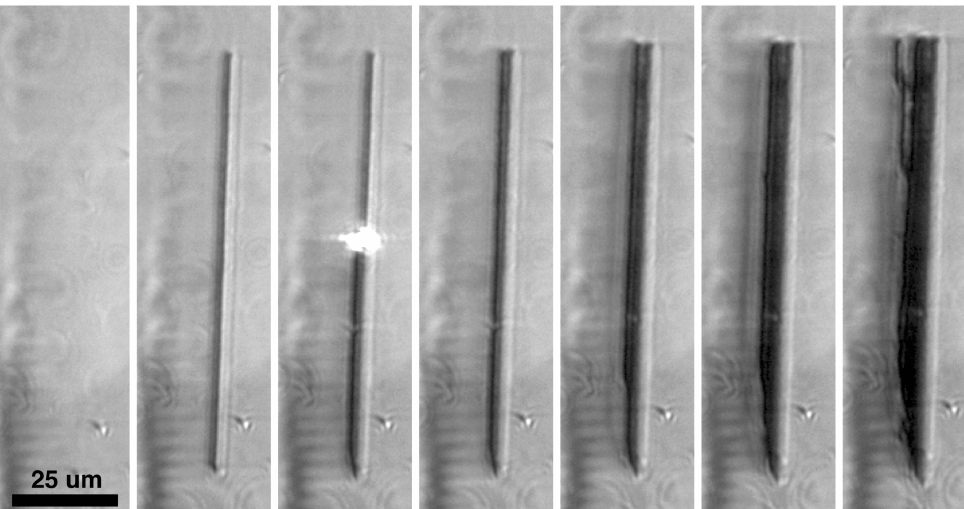
Figure 4. The optimum seed-based laser writing and build-up of graphite wire thickness. Seed stage parameters: E s = 1.0 µ J, V s = 0.2 mm/s. Graphitization stage parameters: E g = 0.3 µ J, V g = 0.05 mm/s. The first image demonstrates the seed scan. The second, fourth, fifth, and subsequent images correspond to the first, second, third, and subsequent graphitization scans. The third image demonstrates 2-nd graphitization scan in the